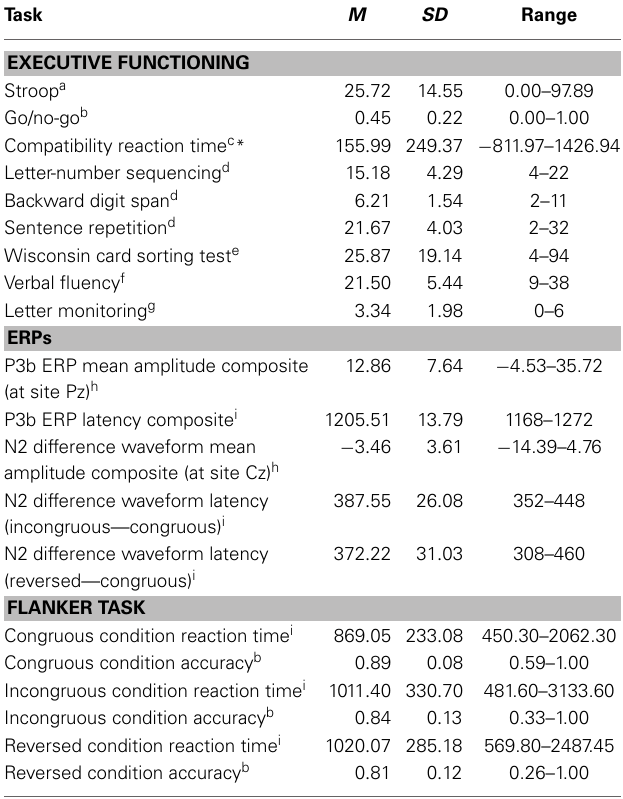
Table 1 | Descriptive statistics of executive function and ERP measures before transformation ( N =